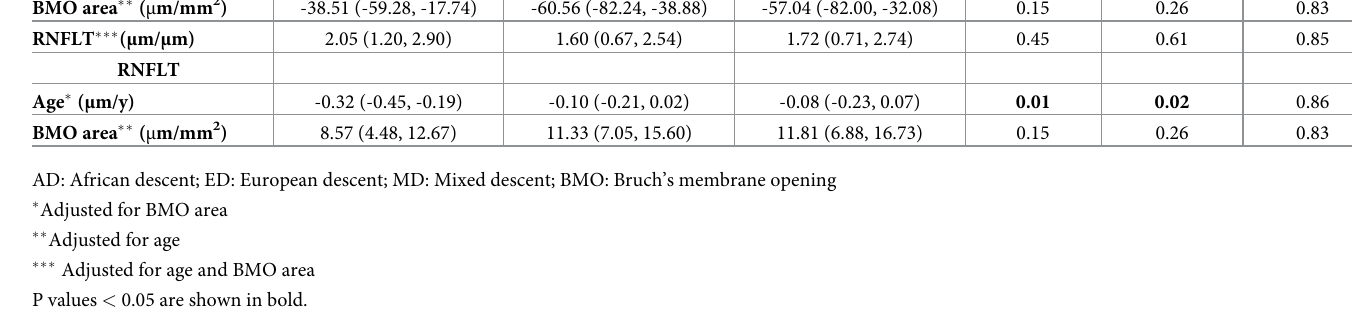
Table 4. Multivariable regression models evaluating the relationship between minimum rim width (MRW) and peripapillary retinal nerve fiber layer thickness (RNFLT) and covariates by racial group. ß (95%